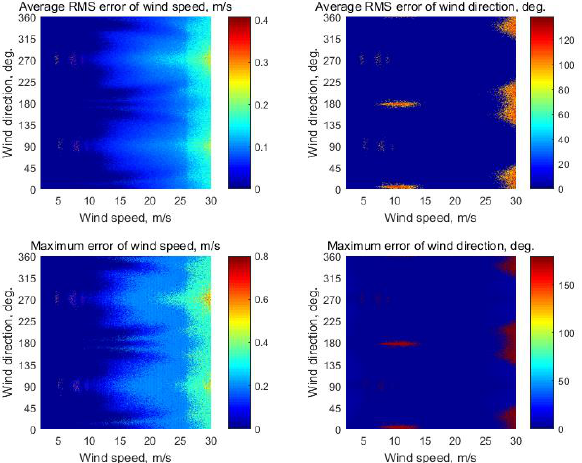
Figure 6. Simulation results for the hypothetical five fan-beam geometry at the wind speeds of 2–30 m/s with 9613 averaged NRCS samples for each combination of the incidence and azimuthal angles.